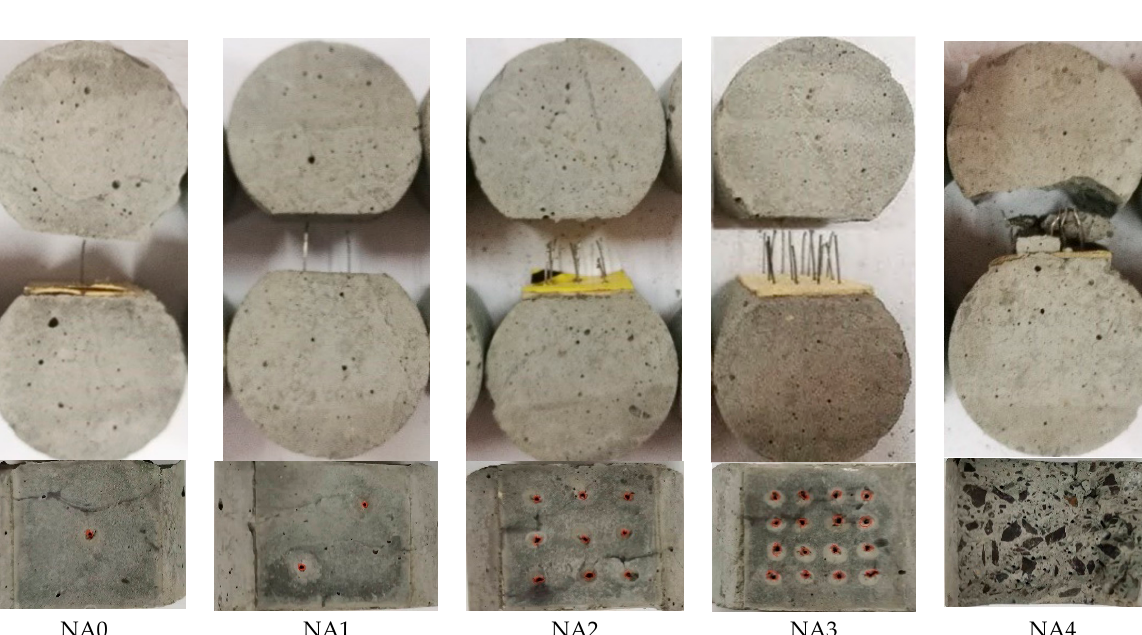
Figure 5. Typical failure mode of Series NA. Based on the above description, in condition of the mortar with a compressive strength around 74.5 MPa, the steel fibers will be pullout with the straightened hook-end. If the inclination angle of steel fiber is over than 30°, the mortar will be peeled off from the transversal section. When the fiber spacing is 3.5 mm, the mortar surrounded the steel fibers can be scraped out during the pulling out of steel fibers. This indicates the bond performance will be affected by the orientation and distribution of steel fiber in concrete